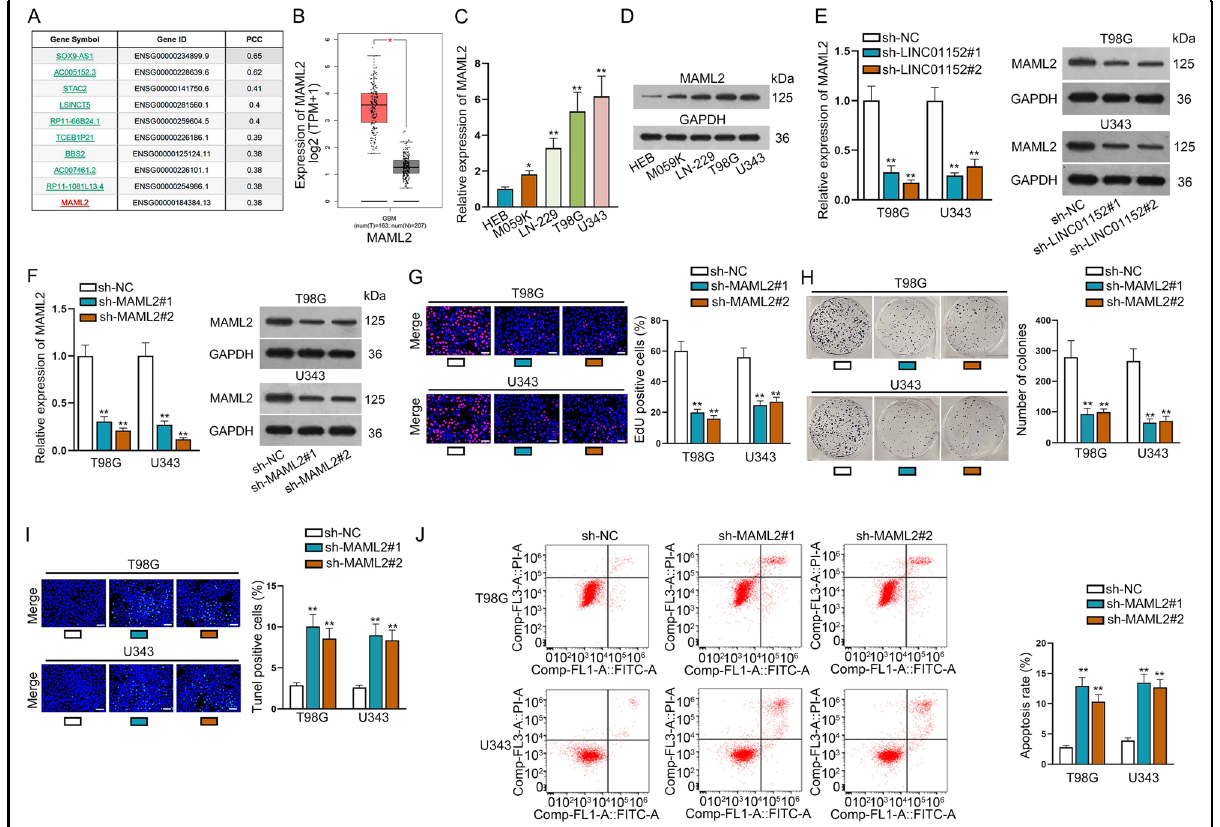
Fig. 2 LINC01152 could promote the progression of GBM by upregulating MAML2. A LINC01152 related genes were identi fi ed via GEPIA database. B Data of MAML2 expression in GBM was acquired from GEPIA database. C , D The mRNA and protein levels of MAML2 in normal human glial cell line (HEB) and GBM cell lines (M059K, LN-229, T98G and U343) were tested via qRT-PCR and western blot, respectively. E qRT-PCR and western blot identi fi ed the expression of MAML2 when LINC01152 was silenced in T98G and U343 cells. F Silence ef fi ciency of MAML2 was veri fi ed via qRT-PCR and western blot in T98G and U343 cells. G , H EdU (scale bar = 100 μ m) assay and colony formation assay assessed the proliferation of T98G and U343 cells when MAML2 was silenced. I , J TUNEL (scale bar = 120 μ m) assay and fl ow cytometry analysis were implemented to test the apoptosis of T98G and U343 cells when MAML2 was silenced. * P < 0.05, ** P <